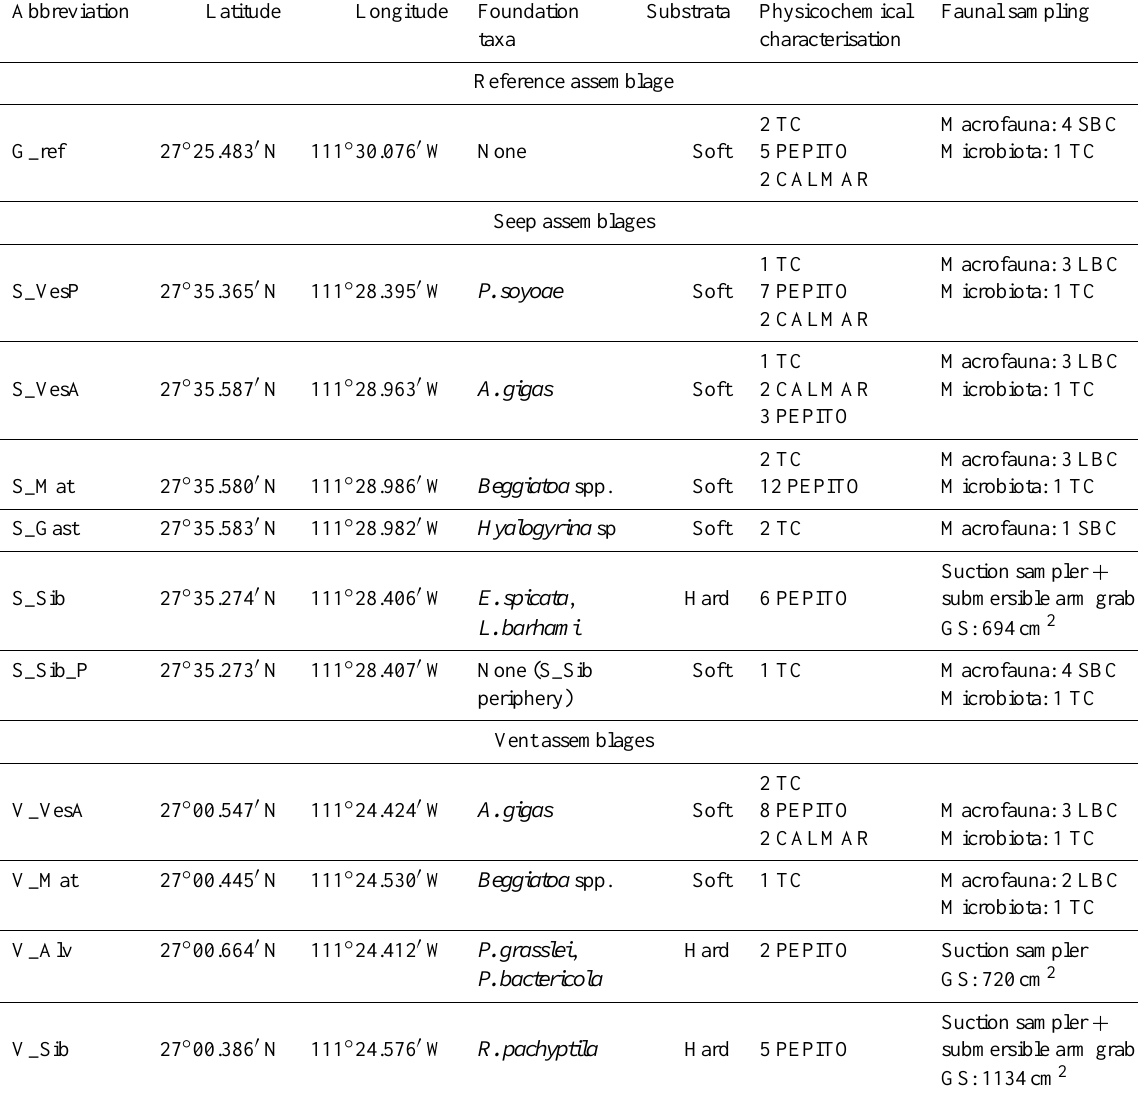
Table 1. Abbreviations, sampling details and locations of the different assemblages sampled in the Guaymas Basin. Blade corers sample a surface of 18cm 2 for the small blade cores (SBC) and 360cm 2 for the large cores (LBC), whereas tube corers (TC) sample a surface of 26cm 2 . GS: ground surface